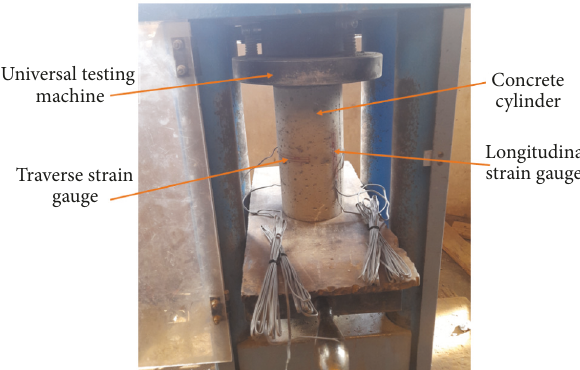
Figure 5: Flexural strength test. Figure